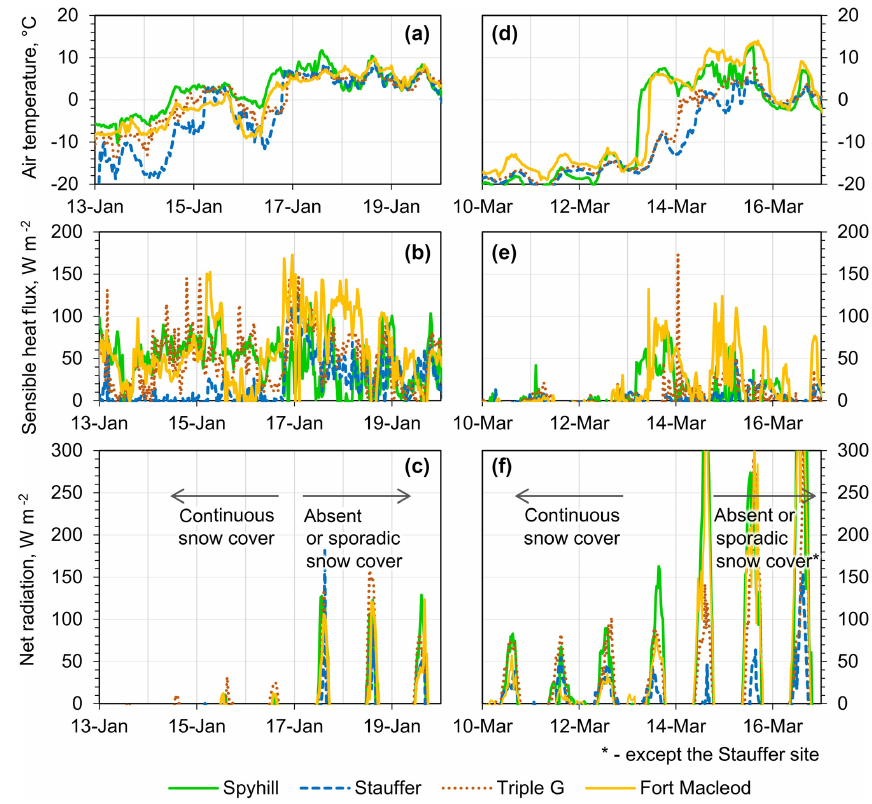
Figure 7. Hourly temperature, sensible heat inputs, and net radiation during selected melt events in winter 2016–2017.